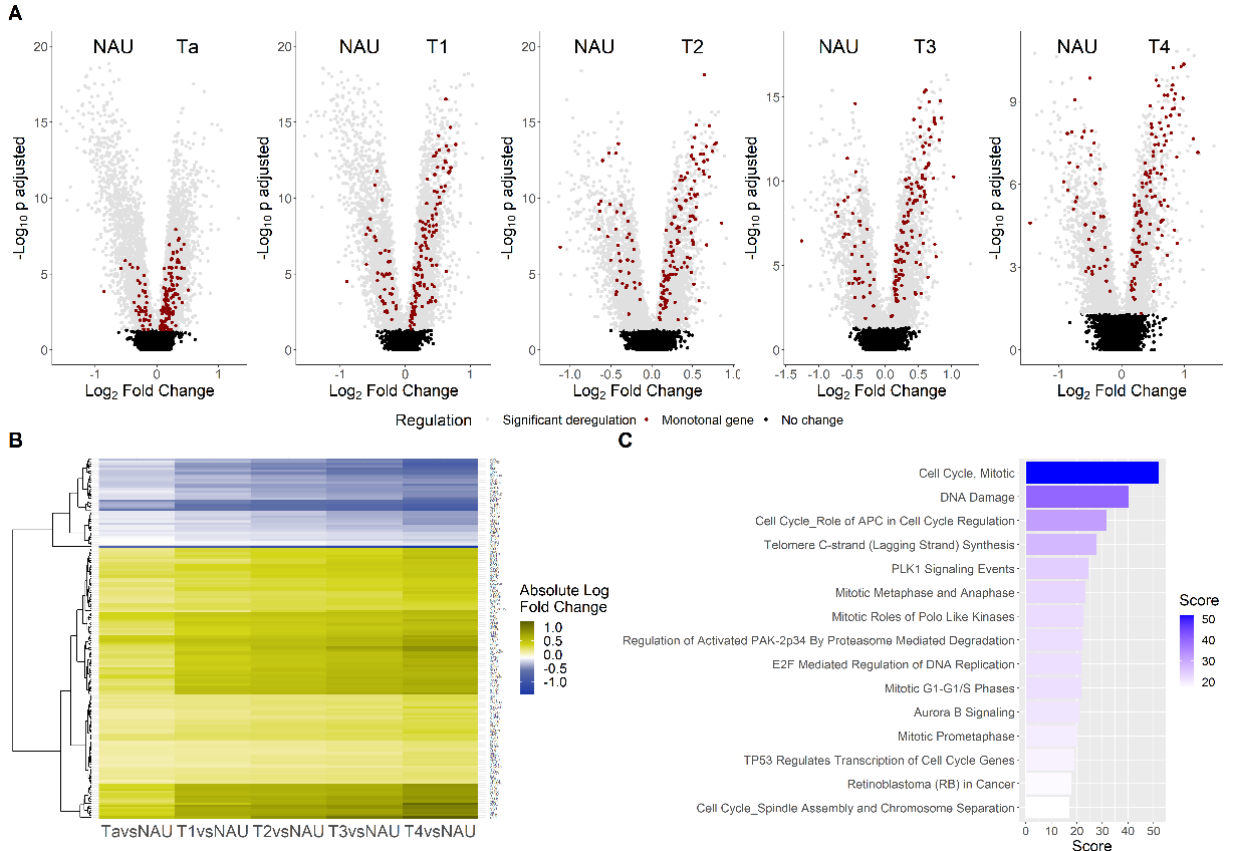
Figure 4. Differential expression analysis between non-malignant adjacent urothelium (NAU) and BLCA stages: ( A ) Volcano plots of the five stages’ comparisons to NAU, with the color red indicating the 157 genes showing a monotonal trend of expression across stages. ( B ) Heatmap of the absolute fold changes of the 157 monotonal genes, which were continuously either up- (yellow) or downreg- ulated (blue), in the comparisons between disease stages and NAU. ( C ) Top 15 pathways of the 157 monotonal genes, sorted by their GeneCards enrichment score.